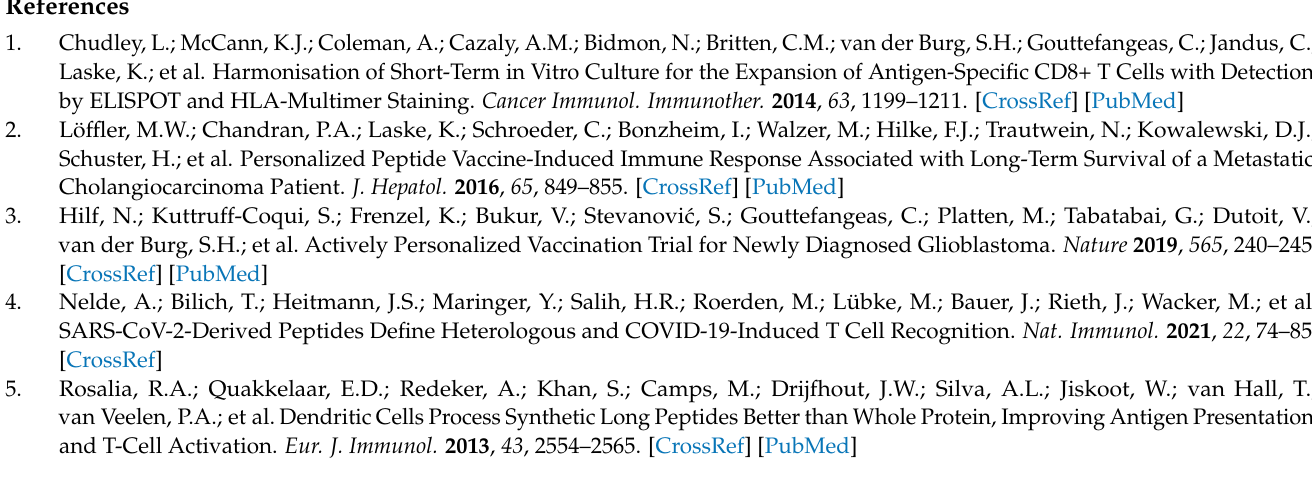
Figure S5: Identification of the optimal EP concentration for the read-out of functional